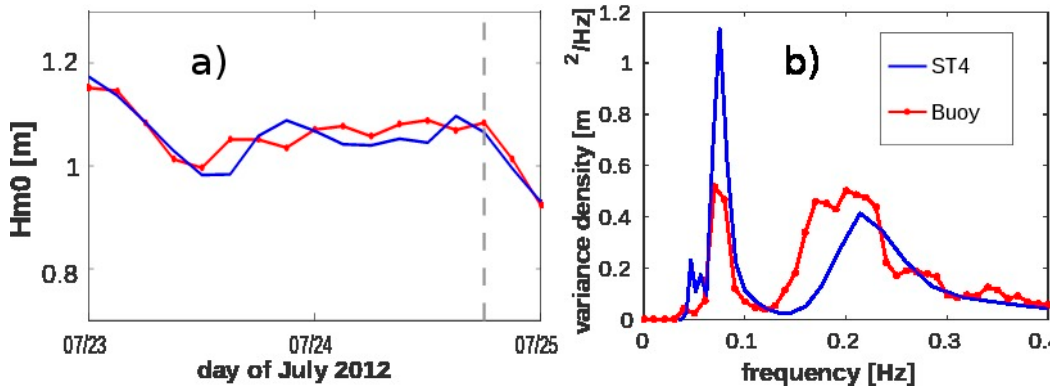
Figure 3. ( a ) Time history of modeled and recorded significant wave height ( H m0 ) at a location off the western equatorial region of South America. ( b ) Corresponding frequency spectra at the time of the vertical dashed line.